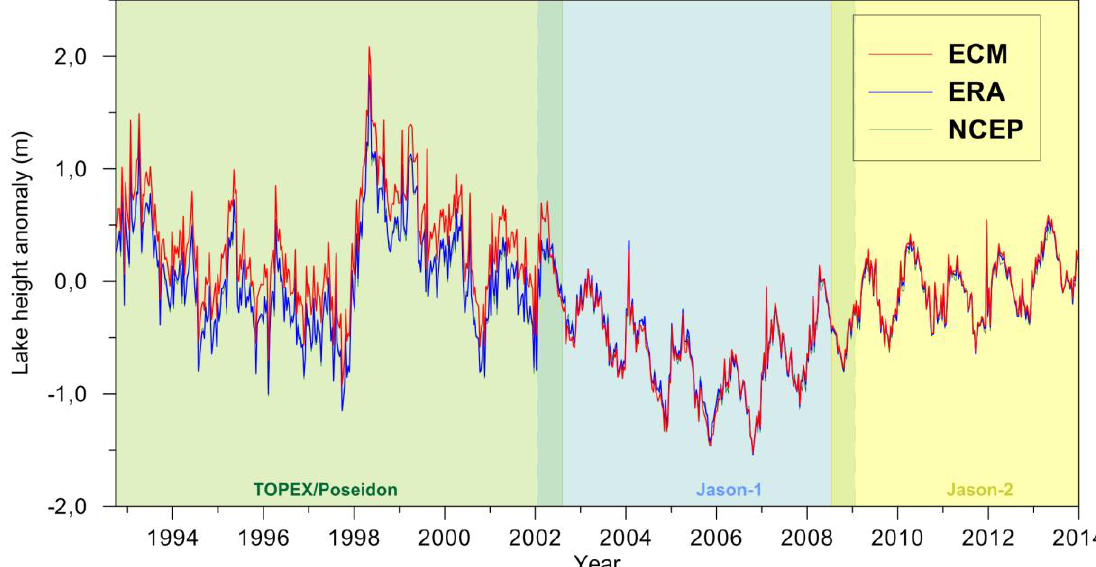
Figure 15. Median water level anomalies (m) for Lake Tanganyika, derived using tropospheric (dry + wet) corrections from three models, for each cycle of T/P Phase A, Jason-1 Phase A and Jason-2. Water level heights are with respect to the EGM2008 geoid. A mean lake height of 769 m has been